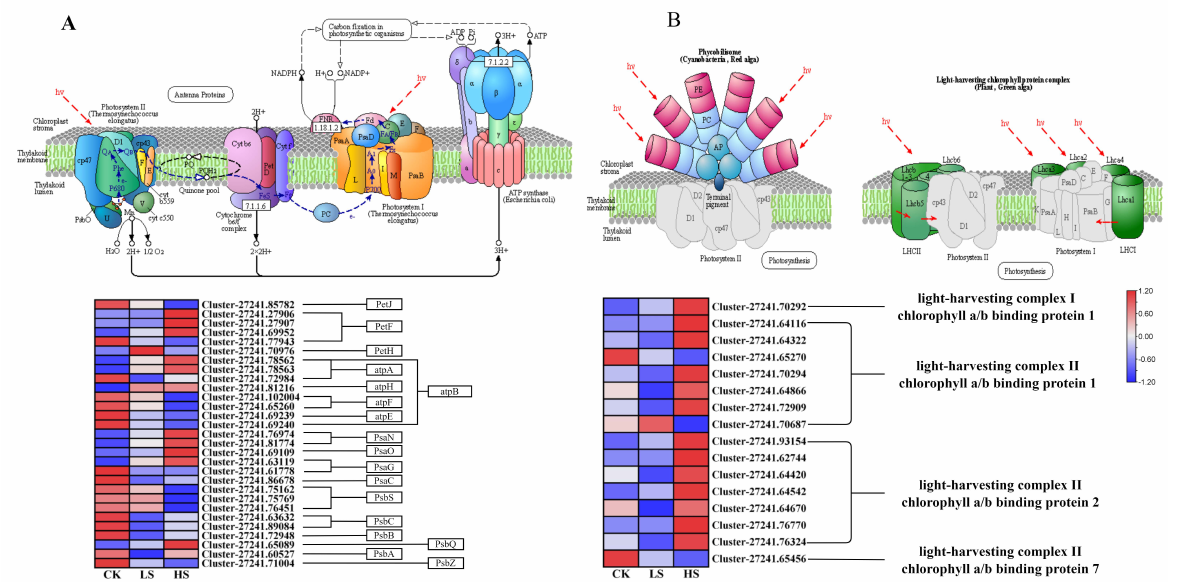
Figure 9. Expression of DEGs involved in response to light and photosynthesis in P. koraiensis under light stress. ( A ) The structure and mechanism of photosynthesis and a heatmap of the expression levels of DEGs involved in photosynthesis. ( B ) The structure of photosynthesis-antenna proteins and a heatmap of the expression levels of DEGs that were found to be involved in response to light stimuli. CK: control. LS: light shade. HS: heavy shade. The color scale from Min (blue) to Max (red) refers to the expression value from low to